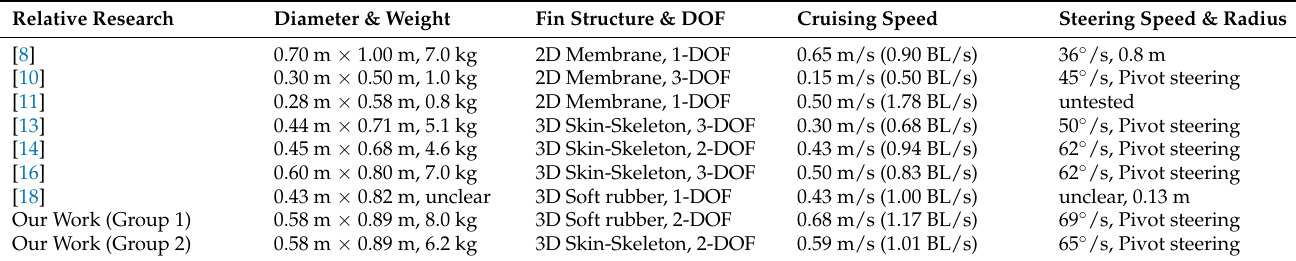
Table 1. Features of different robot ray